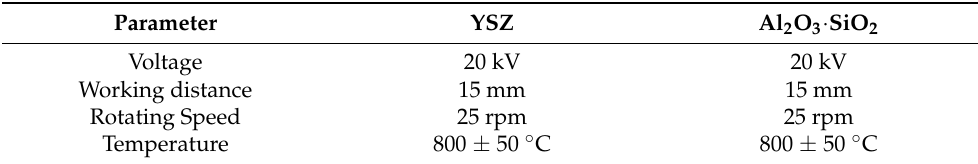
Table 4. TBC Working Parameters.